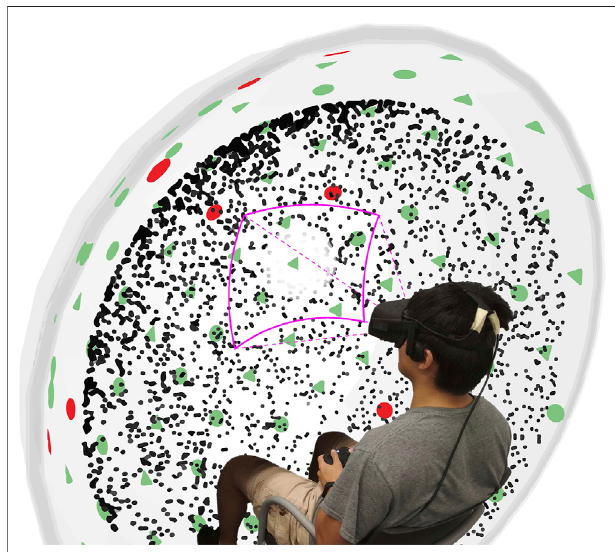
FIGURE 4 | Representation of the search experiment setup. The virtual targets(redcircles) anddistractors(greencirclesandtriangles)wereplacedat a 2-meter radius in a semi-sphere in front of the participant. The GRFs are rendered at a 1-meter radius around the participant ’ s head (for clarity, in this representation, we just show the front half-sphere of the GRFs). The pink area represents the FOV of the HMD. The point of view is changed by rotating the head and body. (Note. The fi gure was shot to explain the experimental design, and the person in the fi gure is the author.)